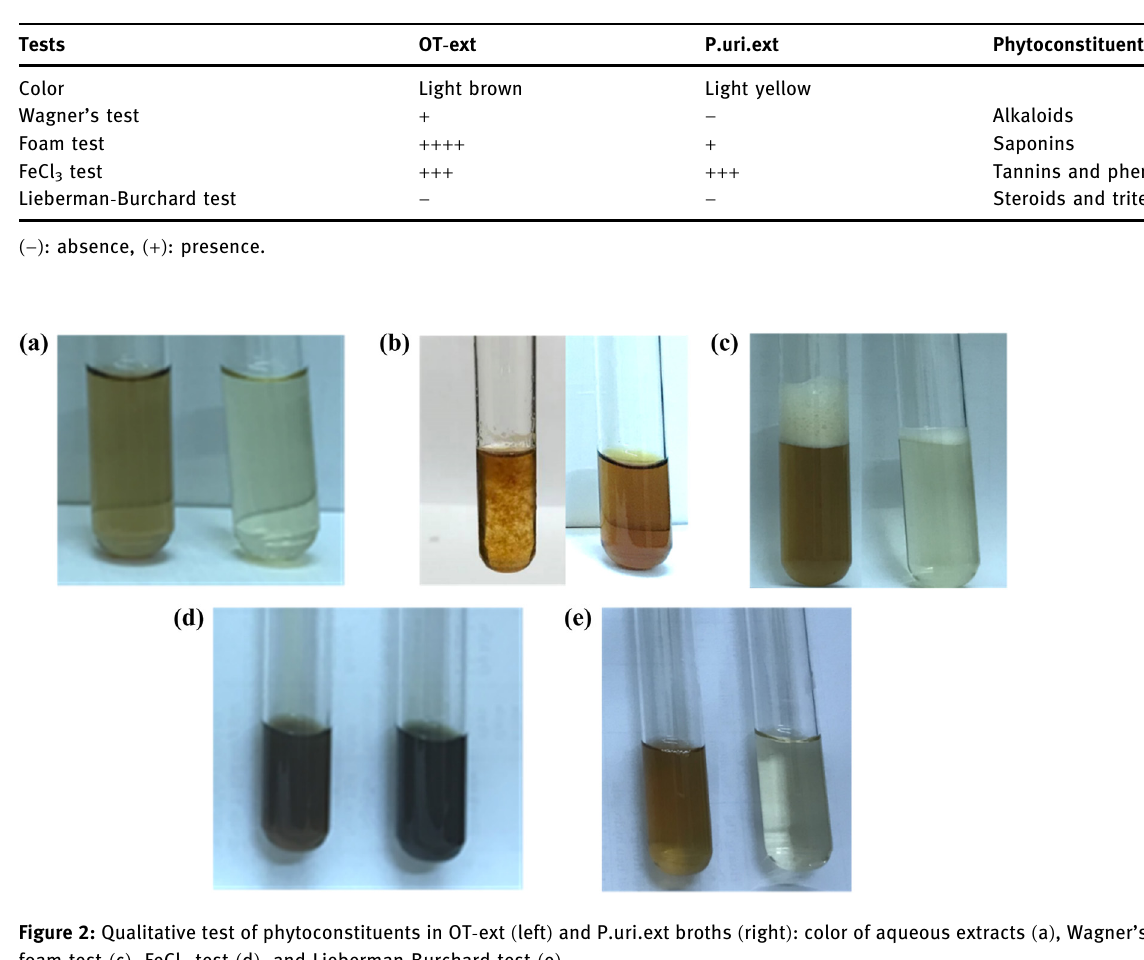
Table 1: Comparison of the phytoconstituents between OT - ext and P.uri.ext broths